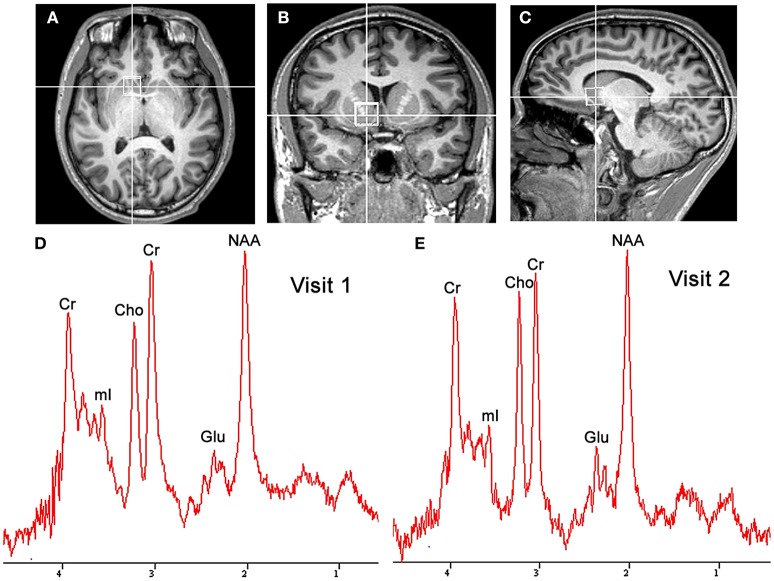
Localized images and representative MR spectra of the nucleus accumbens in the same participant. Localized images of the nucleus accumbens in the axial plane (A), coronal plane (B), and sagittal plane (C) are shown in the listed above. Representative spectra (D,E) from a 1.5 × 1.5 × 1.5 cm3 voxel in the nucleus accumbens for successive scans in the same participant are shown in the listed below. Cho, choline; Cr, creatine; Glu, glutamate; mI, myo-inositol; NAA, N-acetylaspartate.